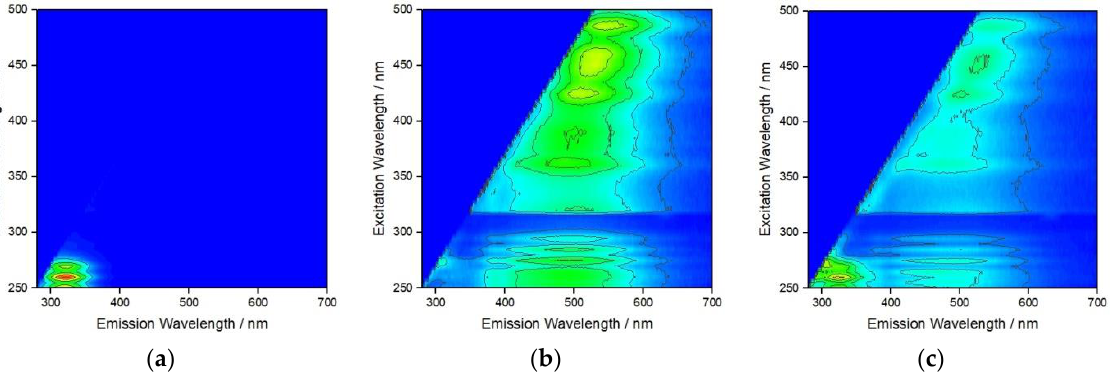
Figure 4. Fluorescence excitation–emission matrix for AgNP after addition of ( a ) BSA at S·0, ( b ) BSA + HA at S·10, and ( c ) BSA + HA + Alg at S·38. (BSA, HA and Alg concentrations of 10, 10 and 1 mg L −1 , respectively).